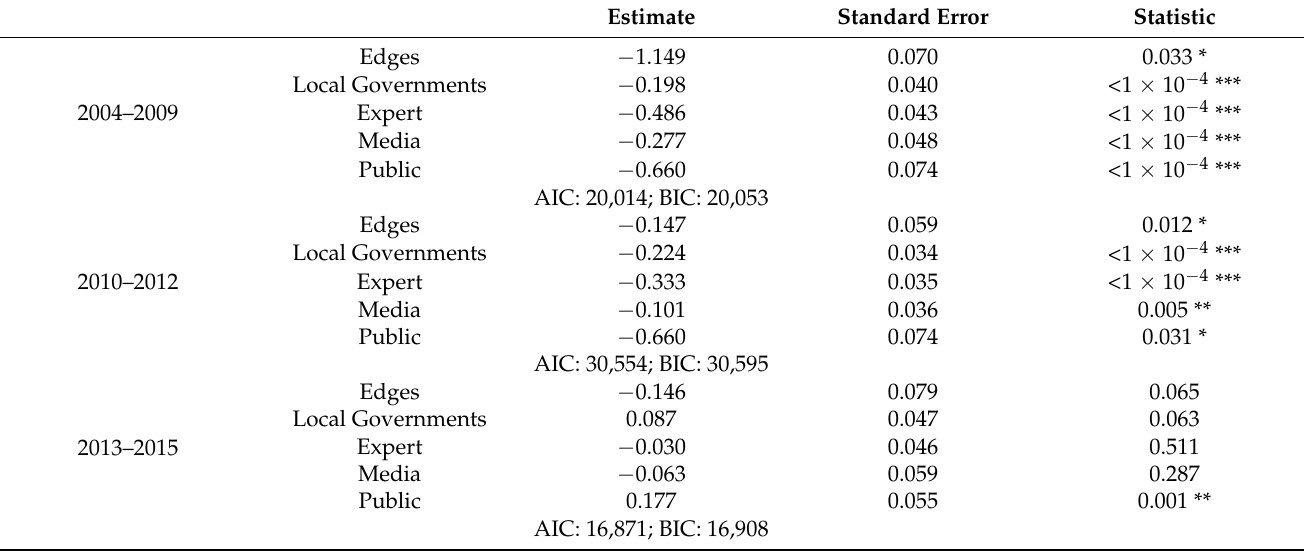
Table 9. Main effect model of discourse network. Estimate Standard